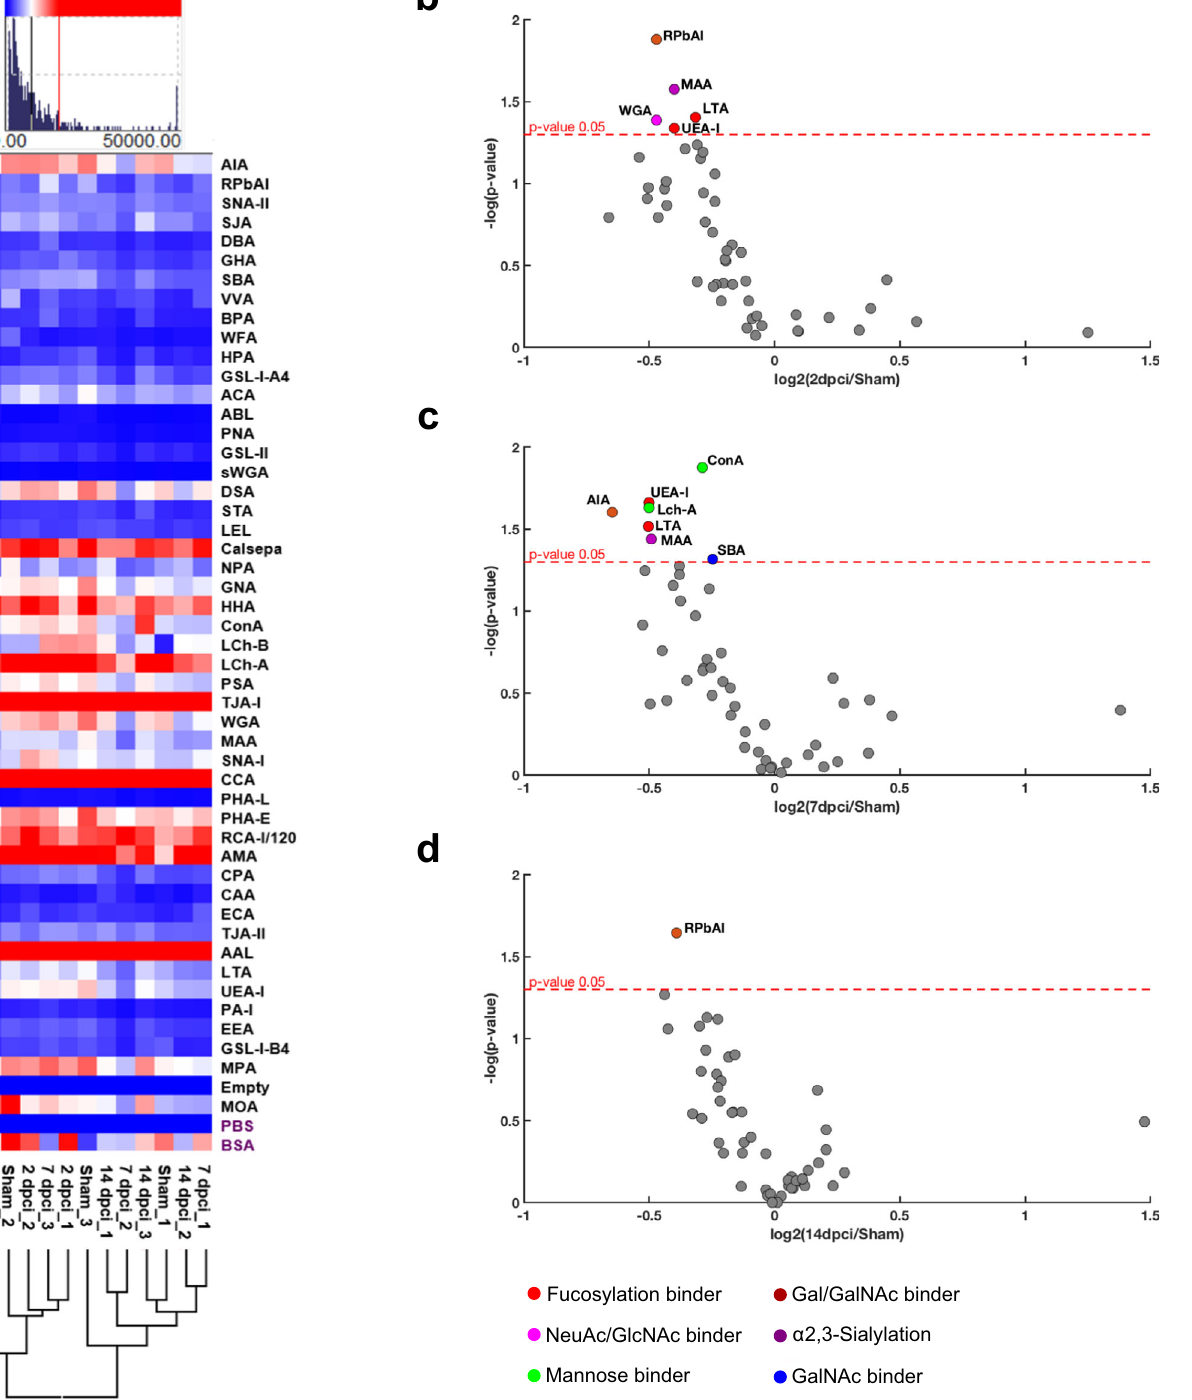
Fig. 3 Lectin microarray analysis evidences cell membrane sialylation alterations in zebra fi sh heart during regeneration. a Hierarchical clustering of lectin microarray data. Asialofetuin (ASF) was used as control glycoprotein and all lectin binding intensities were normalized. b Lectin microarray dot plot of 2 dpci, c 7 dpci and d 14 dpci in respect to the sham showing a reduction of: sialylation (MAA, WGA), fucosylation (LTA, UEA-I), GlcNAc (WGA) and Gal/GalNAc (RPbAI) at 2 dpci; sialylation (MAA), fucosylation (LTA, UEA-I), mannose (Con A, Lch-A), Gal/GalNAc (AIA) and GalNAc (SBA) at 7 dpci; and Gal/GalNAc (RPbAI) at 14 dpci. One-way ANOVA analysis with Tukey ’ s post hoc correction was applied. Spot colors correspond to lectin sugar speci fi city; the red dotted line represents a signi fi cant cutoff of p value ≤ 0.05. Three biological replicates were analyzed, each one deriving from the pooling of 4 different animals ( n =